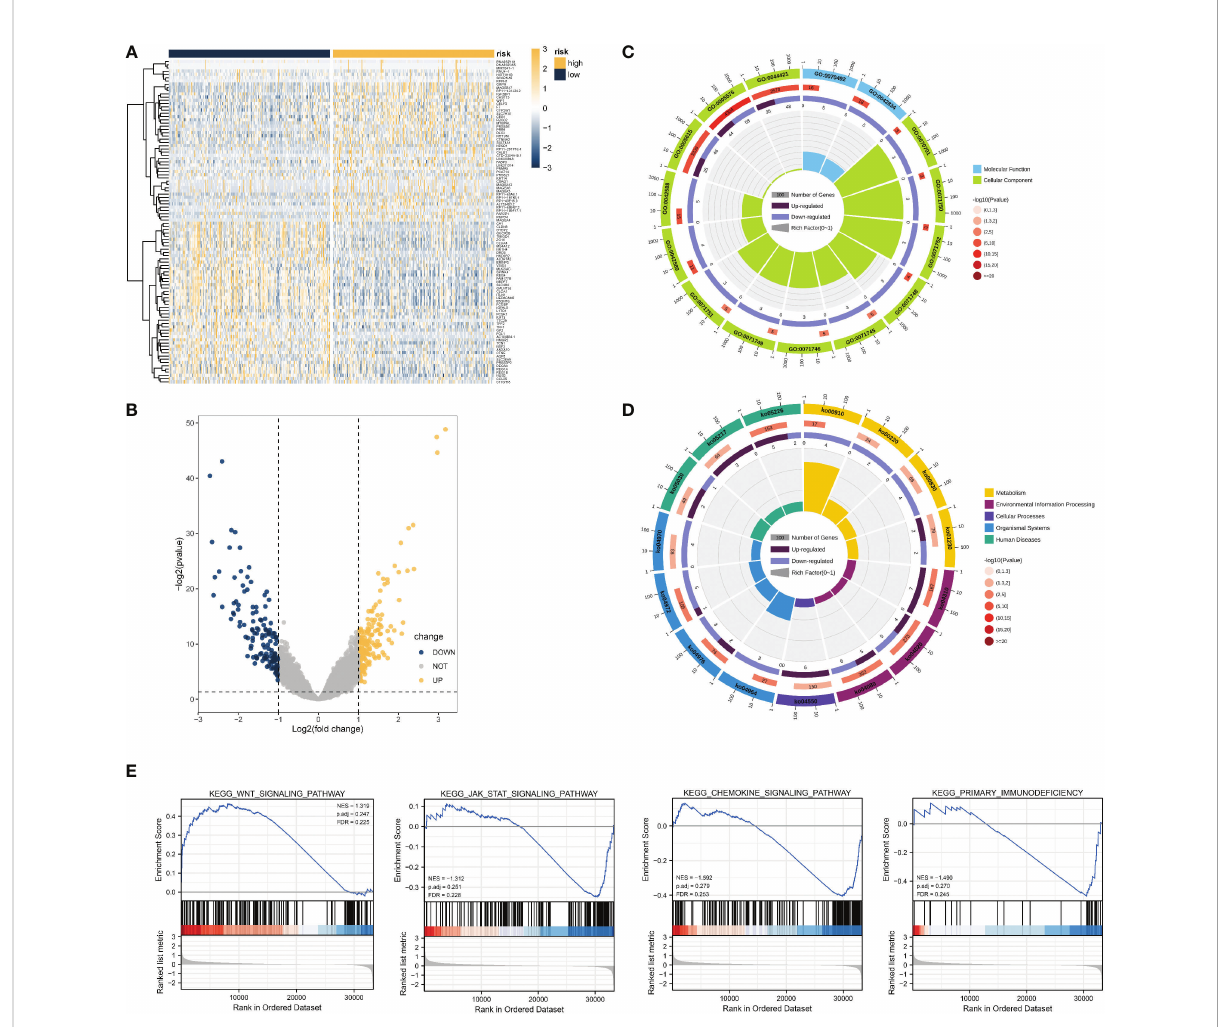
FIGURE 5 DEG analysis and functional enrichment analysis based on the necroptosis-related risk model. (A, B) Volcano map and heat map revealing DEG expression between the high- and low- risk groups in TCGA-COAD dataset. (C) GO analysis revealed that the differential genes were correlated with GO:0044421 extracellular region part, GO:0005576 extracellular region, GO:0042588 zymogen granule, GO:0071752 secretory dimeric IgA immunoglobulin complex, and other functions. (D) KEGG results revealed that these DEGs participated in nitrogen metabolism, bile secretion, rheumatoid arthritis, and other pathways. (E) GSEA results suggested that the KEGG results were similar to those of differential gene enrichment, and the main enrichment pathways were the WNT pathway, JAK-STAT pathway, immune-related pathway,